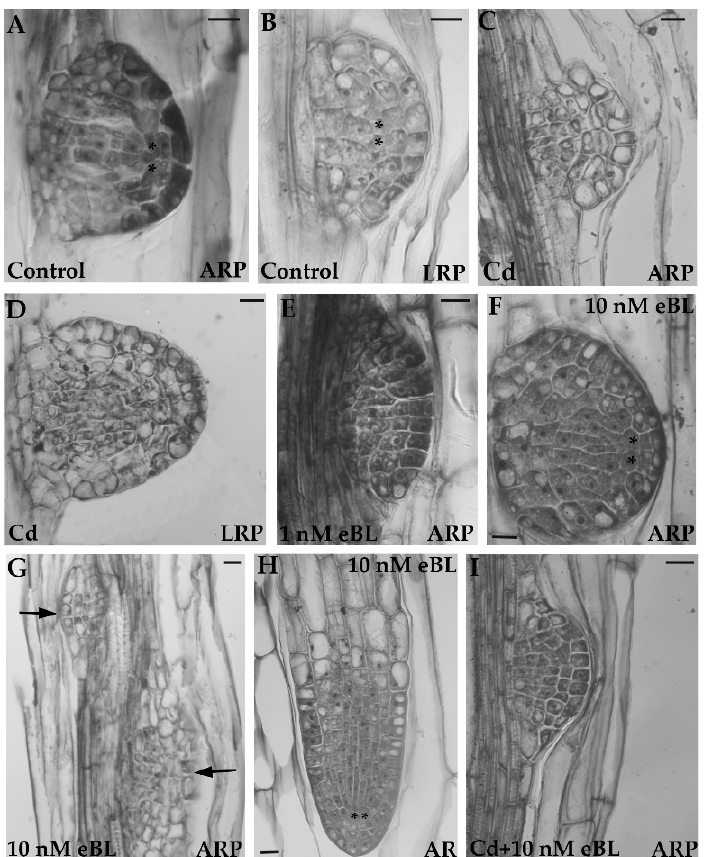
Figure 1. Histological images of adventitious root primordia (ARP, ( A , C , E – G , I )) lateral root primordia (LRP, ( B , D )) and apices of adventitious root (AR, ( H )) formed following either the anticlinal proliferation of the hypocotyl pericycle (ARPs) or the anticlinal proliferation of the primary root pericycle (LRPs) in Arabidopsis thaliana seedlings (Col ecotype) cultured for nine days with continuous darkness followed by seven days under 16 h light/8 h darkness photoperiod, according to [27]. ( A , B ) regular ARP ( A ) and regular LRP ( B ) at stage VII of development, formed on the control medium, i.e., with no exogenous phytohormone (Control). The regular quiescent center (QC) presence is shown by the asterisks. ( C , D ), ARP ( C ) and LRP ( D ) at stage VII or soon after, showing irregular apical structure under the treatment with 60 µM of CdSO 4 (Cd). ( E , G ) ARPs at different developmental stages showing regular QC definition at stage VII ( F ). Treatments with either 1 nM of 24-epibrassinolide (eBL) ( E ) or 10 nM eBL ( F , G ). Arrows in ( G ) show ARPs located very near each other. The image is representative of the high density of roots obtained with 10 nM eBL [27]. ( H ) AR apex with regular QC (showed by asterisks) under 10 nM eBL. ( I ) young regular ARP (stage of dome definition, [8]) formed in the combined presence of Cd and 10 nM eBL. Longitudinal radial sections stained with toluidine blue and presented in black and white. Data from Della Rovere et al. [27]. Bars = 10 µ